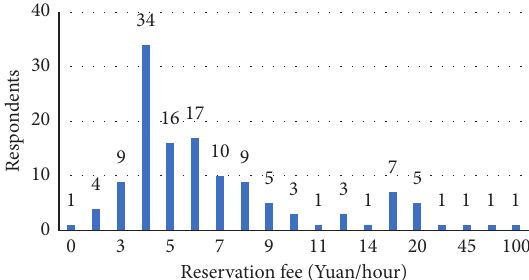
Figure 9: Reservation fee for 70% success.